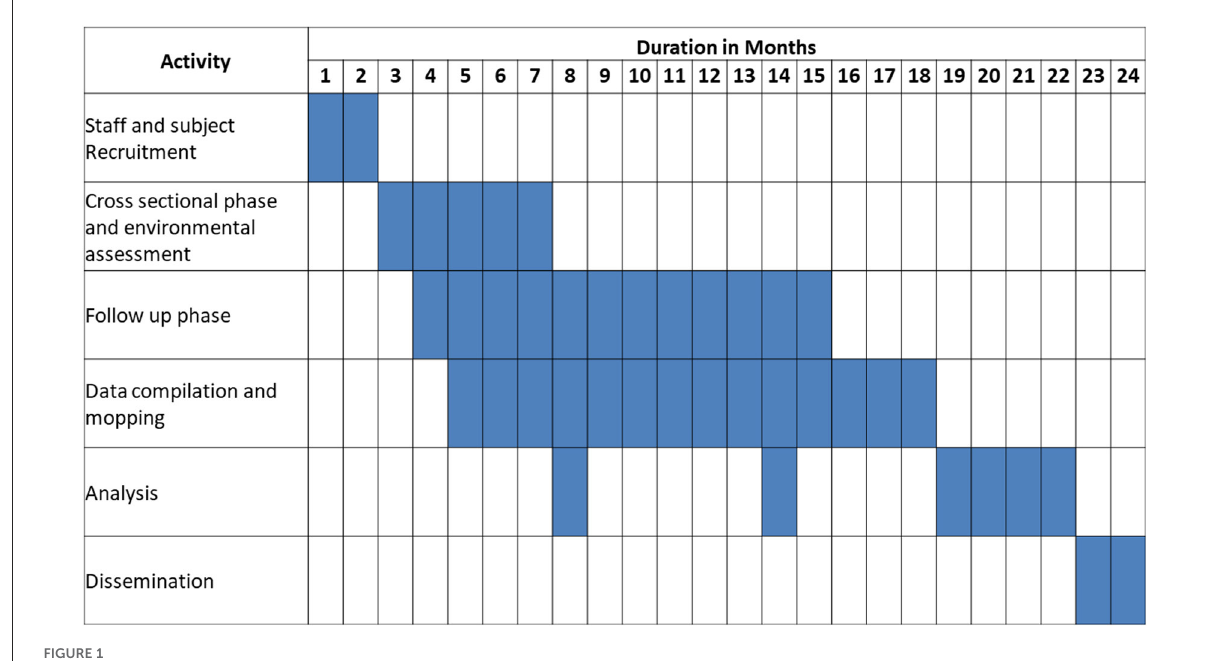
FIGURE1 Gantt chart of the project